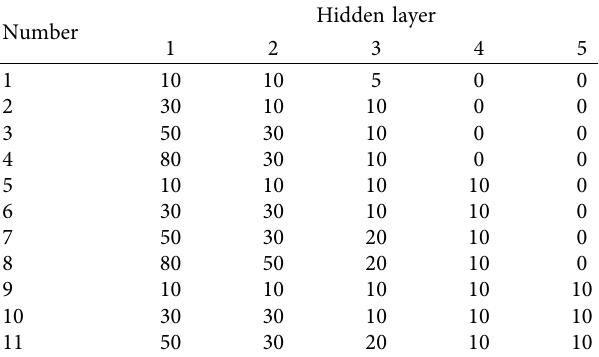
Table 1: Different network structure selections of the DRNN-EMS